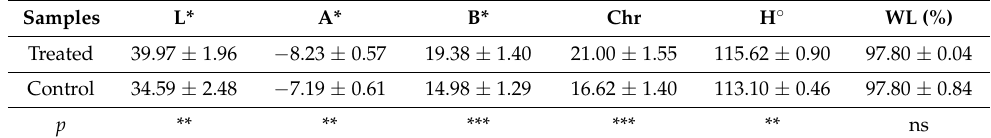
Table 1. Color parameters and weight loss in untreated samples (Control) and in rocket leaves treated with Bortan